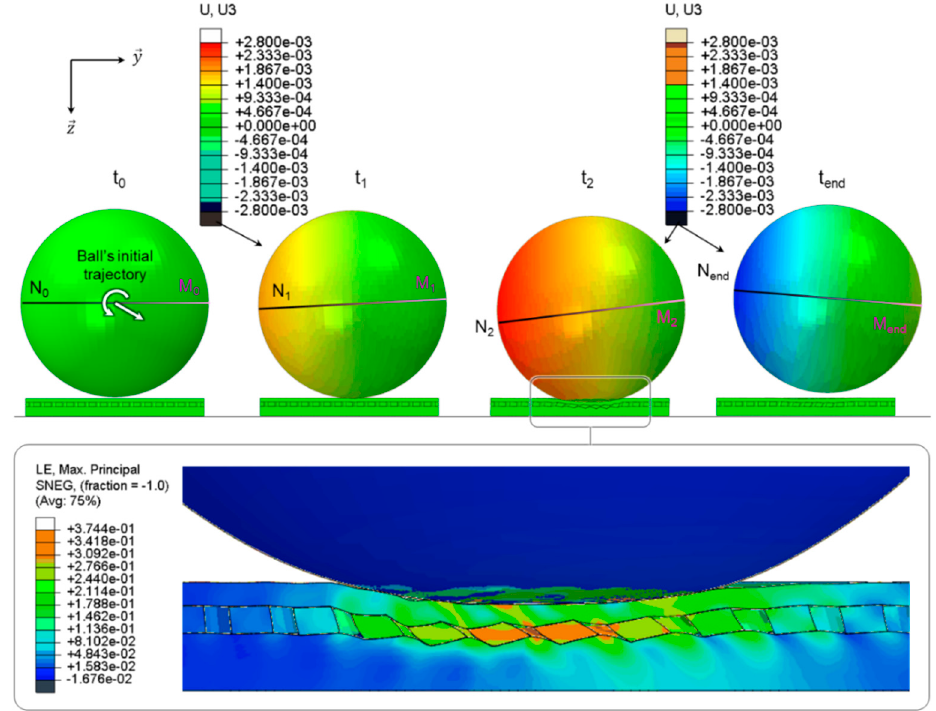
Figure 9. Simulated vertical displacement mapping of a ball impacting the foam + compact target at 4 distinct times ( α i = 60° angle, V i = 14 m/s and ω i = − 66 rev/s). The inset figure focuses on the through-thickness deformation profile at maximum depth during contact.